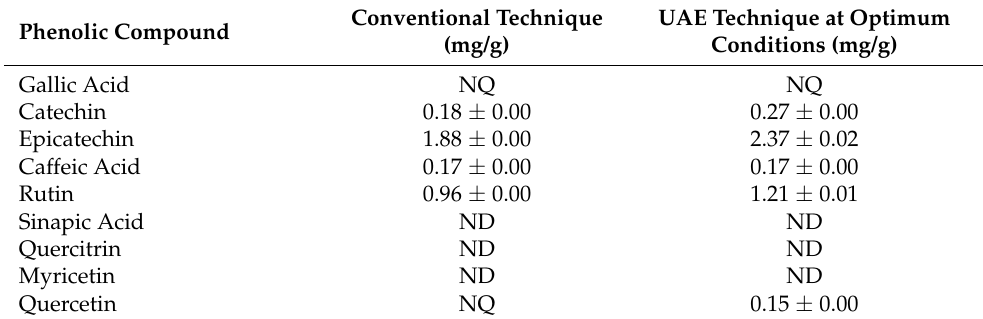
Table 4. Concentration of the detected phenolics in black cumin expressed as mg/g of dry extract ( n = 3).